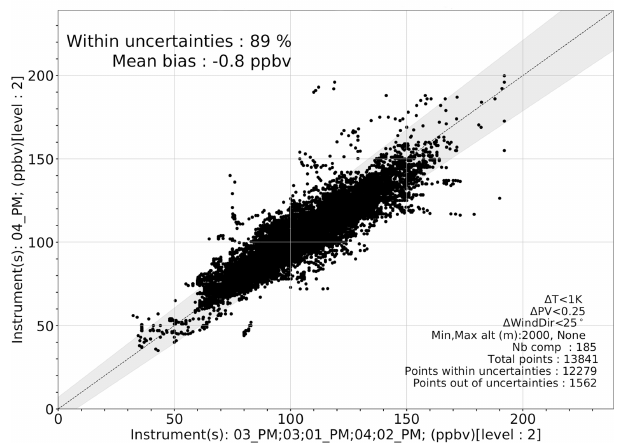
Figure 8. Scattergram plot compiling all the flight intercompar- isons found for CO MOZAIC instrument serial number 04 PM for FP no. 13 on Lufthansa A340 msn53. The gray area represents the total measurement uncertainty. Statistic scores are presented in the figure legend.